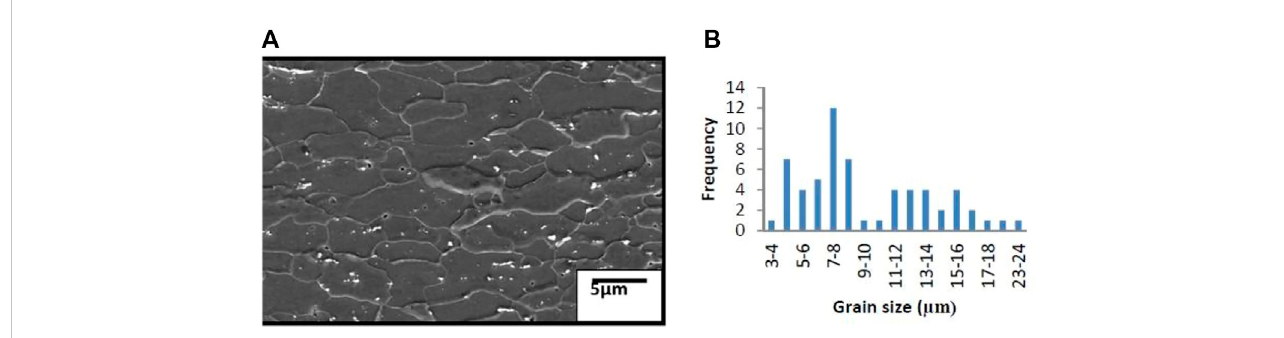
FIGURE 7 (A) SEM micrographs and (B) grain size distribution of the